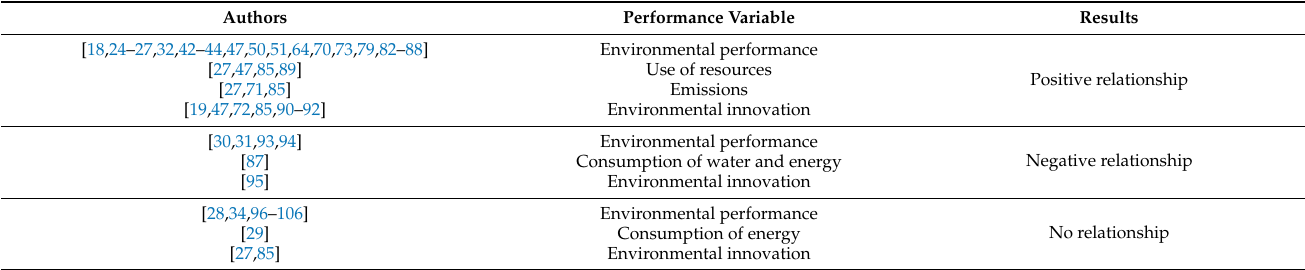
Table 1. Review of studies of the relationship between gender diversity and environmental performance. Authors Performance Variable